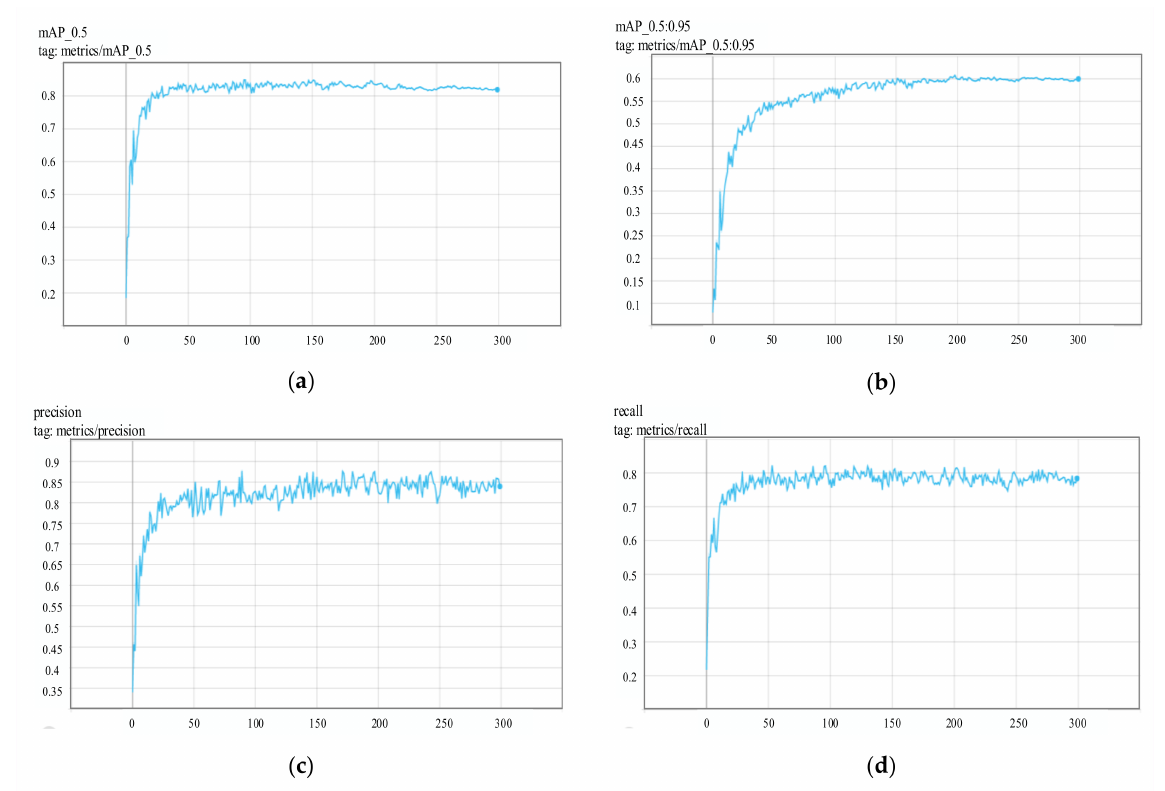
Figure 11. Changes of evaluation indicators. ( a ) mAP @0.5; ( b ) mAP @0.5:0.95; ( c ) precision; ( d ) recall.